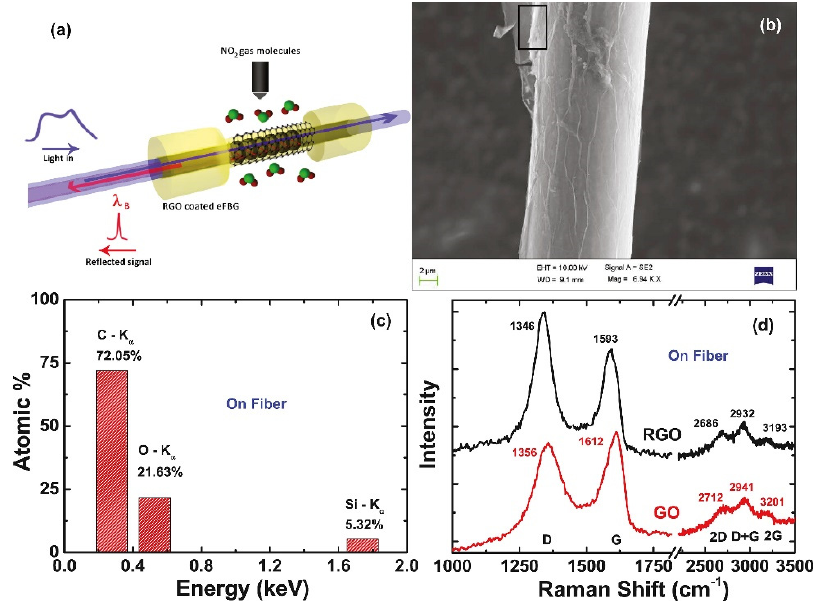
Figure 7. ( a ) Schematic illustration of the NO 2 gas-sensing mechanism on the RGO-coated eFBG. ( b ) SEM image of the eFBG sensor showing uniformly coated RGO in the FBG region. ( c ) EDAX spectra recorded from RGO flakes (designated by the black-colored rectangular box in Figure 6a) coated on the eFBG sensor surface. ( d ) Raman spectra of GO flakes (coated on eFBG sensor), before and after the reduction. Reproduced from [99] with permission of Elsevier.